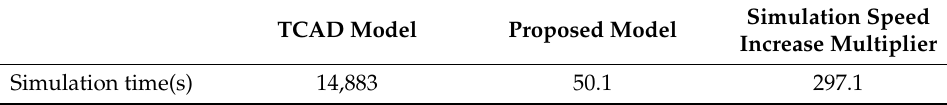
Figure 9. Multi-timescale co-simulation. Table 6. Multi-timescale joint simulation